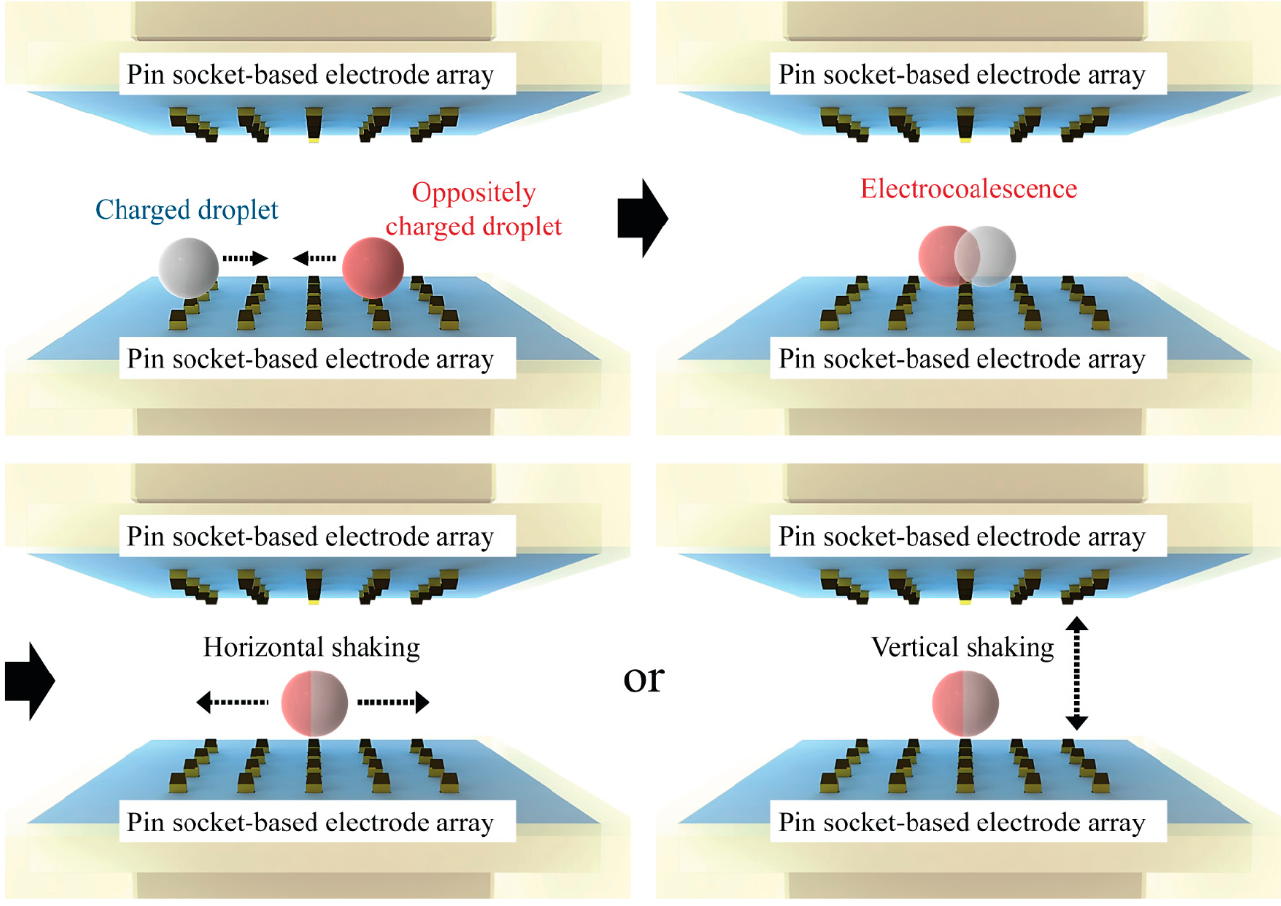
Figure 1. Conceptual diagram of the proposed digital microfluidic mixing via the reciprocating motion of droplets driven by contact charge electrophoresis.